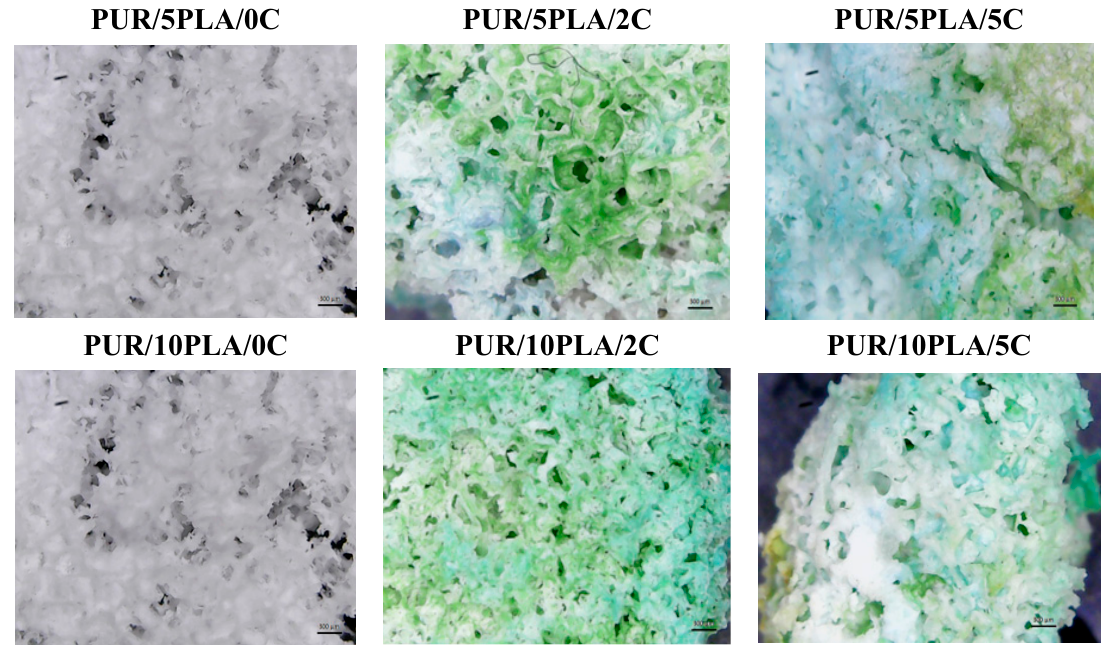
Figure 8. Optical microscopy images of unmodified and Cipro-modified HPPS obtained by using 10 wt % after 15 days of incubation.